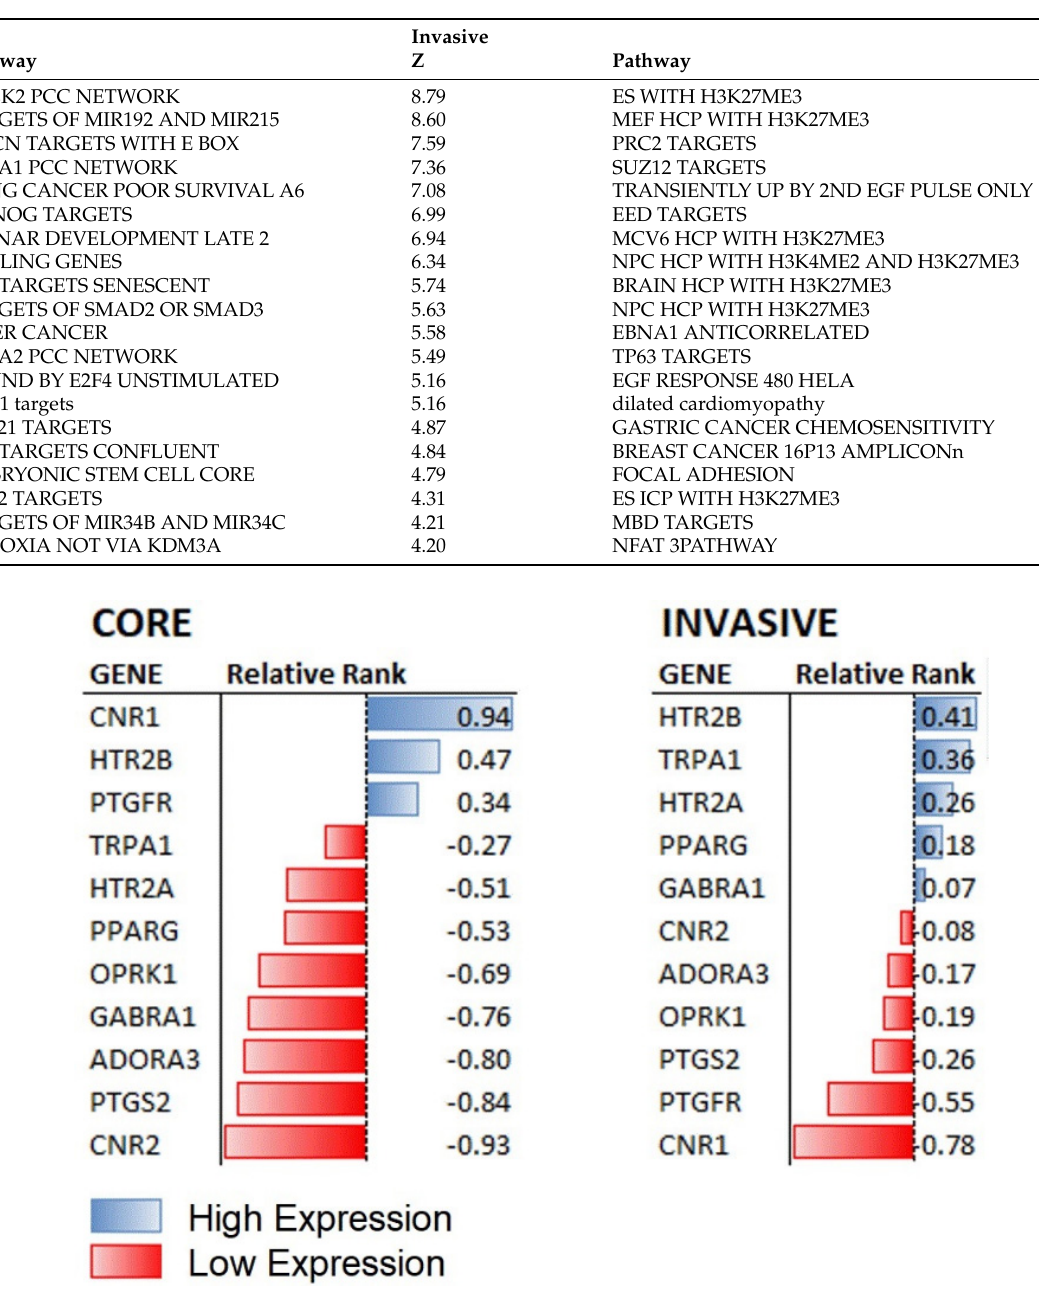
Table 2. Positively enriched pathways in the GPR profiles for the core and invasive margin cells. As expected, the core cells show a large positive enrichment with a series of cancer-associated pathways, shown at left. In contrast, the invasive GPR enrichment scores are more modest and reveal a distinctly unique pathway enrichment relative to the core. The full list of enriched pathways is given in Table S3.